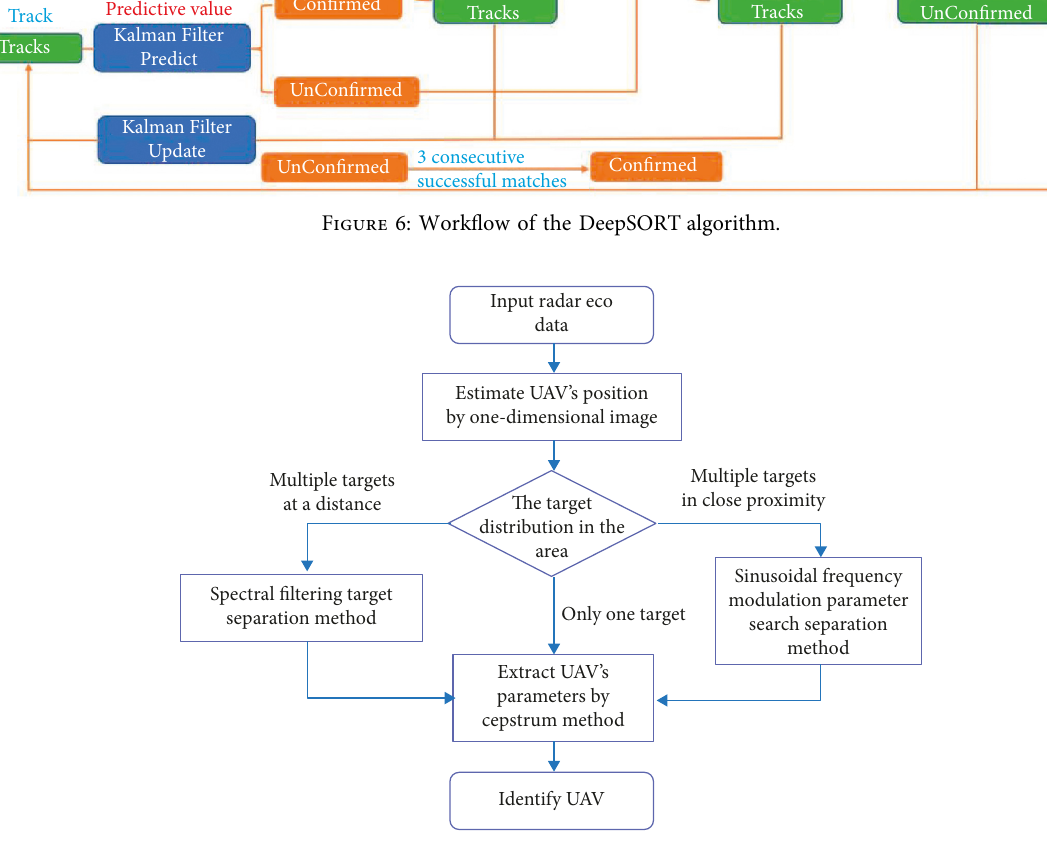
Figure 7: Identification of UAV by the radar